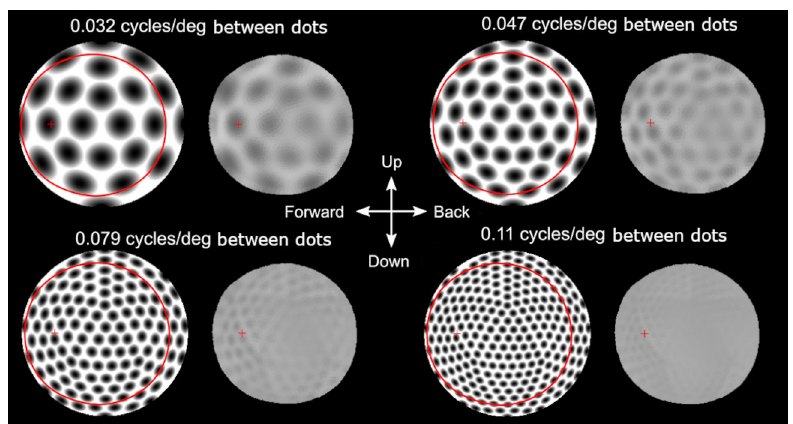
Fig 7. Resolution of test images. Input images and filtered images are shown for four different spatial frequencies (in each pair, the input image is to the left and the filtered output to the right). The smaller size of the filtered images reveals the limited visual field and is shown by the large red circle in the input image. The small red cross indicates the centre of the area with highest resolution. The input image is made up by 2d Bessel functions in a hexagonal grid on a sphere surrounding the eye so that the angular distance between each “dot” is roughly the equal to all near neighbours. It is this 3d image that is filtered by the eye. The stimuli are then projected on the 2d plane as a flattened 180˚ half sphere by an equisolid angle projection for visualization and the filtered signal is plotted with the same projection. The viewing directions for the right eye are indicated in the centre.